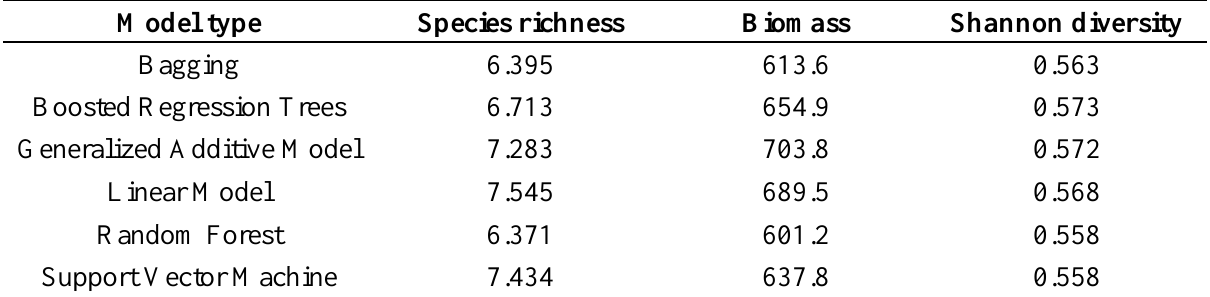
Table 3. Average cross-validated RMSE values for each response variable and model type (biomass and diversity variables were re-transformed prior to RMSE